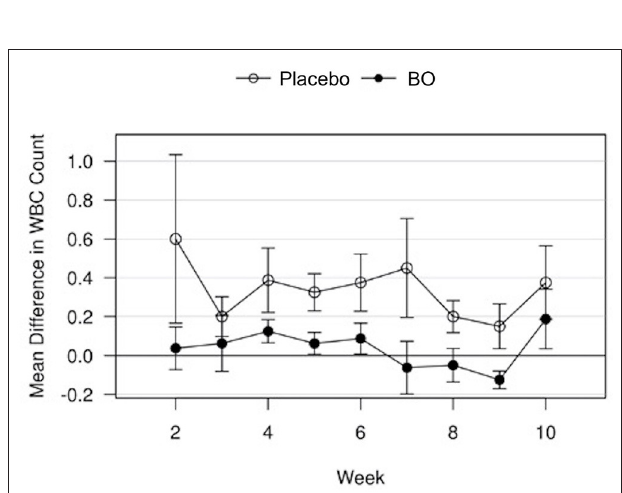
FIGURE 5 | Mean differences in synovial white blood cell (WBC) counts for placebo and BO treated horses. Measurements are in terms of changes from baseline. Values were also adjusted to accommodate the values of the sham operated joint, such that the means represented here are based on the following equation: d i , t = (cid:0) x i , OA , t − x i , sham , t (cid:1) − (cid:0) x i , OA , base − x i , sham , base (cid:1) . A significant difference ( p = 0.005) was found when evaluating across all time points, but no single time point was significantly different. Error bars represent + /- 1 standard error. Units are cells x 10 3 /uL.